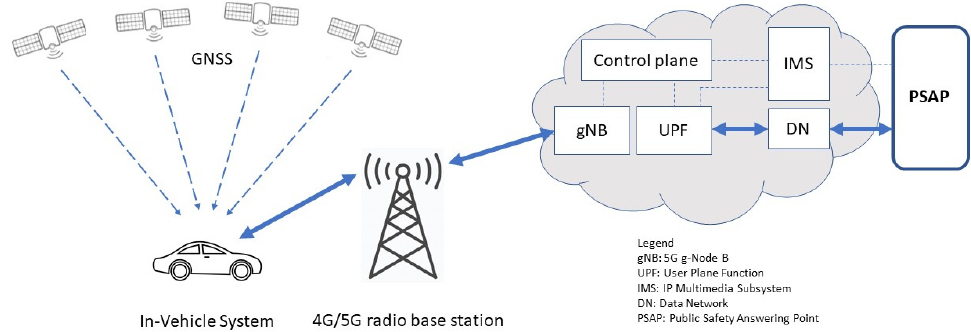
Figure 3. Next Generation eCall system architecture (5G case).